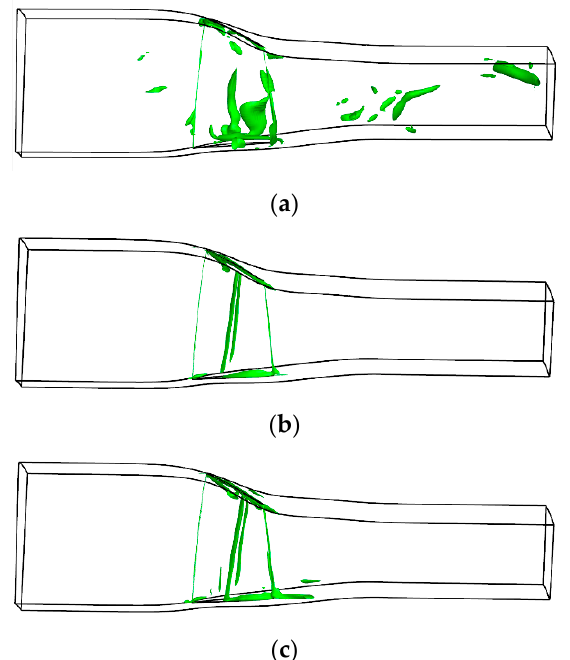
Figure 10. Iso − surface of Ω value 0.52 in the NASA rotor 37 at ( a ) NS condition, ( b ) design condition, ( c ) NC condition.